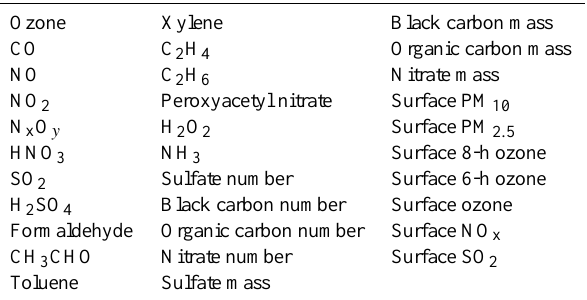
Table 5. List of all species simulated by the urban metamodels. Unless otherwise stated as being a surface variable or having a spe- cific temporal averaging, all species are simulated as a daily average value at each vertical